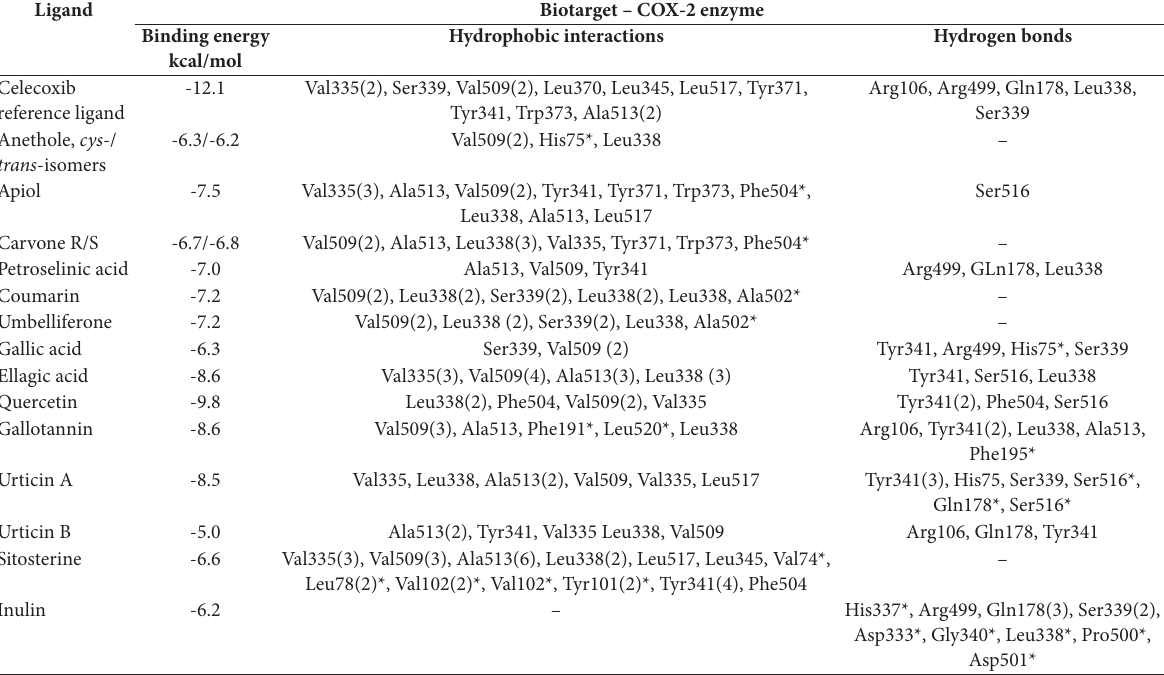
Table 2. Docking results for the studied natural compounds into the СОХ-2 inhibitor active site. Ligand Binding energy